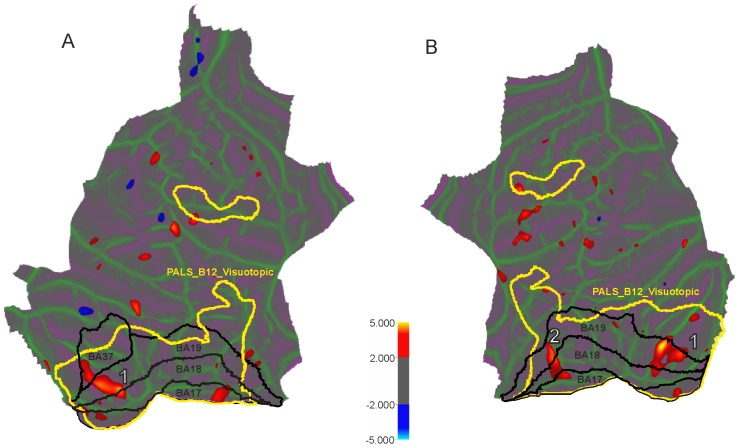
Localization of surface clusters where cortical thickness is significantly reduced in the POAG subjects in comparison to normal controls (p<0.02, uncorrected) for left (A) and right (B) hemispheres.The cold colour represents significantly increased cortical thickness in POAG subjects compared with controls, while the hot colour represents significantly decreased cortical thickness. Yellow lines delineate visuotopic areas taken from PALAIS_B12.Visuotopic cortical atlas. Black lines correspond to the Brodmann areas related to the study. White numbers correspond to clusters surviving the p<0.001 level multiple comparison correction procedure (see Table 2 and 3 for coordinate and cluster size information).